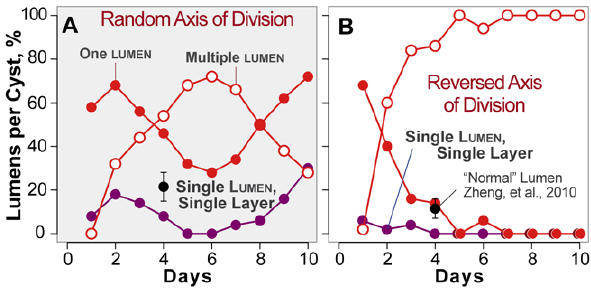
Figure 6. Percentage of ISMA CYSTS with varied LUMEN number when the axis of CELL DIVISION is abnormal. Shown are the percentages of CYSTS that have single (solid red circles) or multiple (open red circles) LUMENS when the axis DIVISION is (A) random or (B) reversed (rotated 90 u ) along with the percentage of CYSTS that are SLSL (purple circles) when the axis of CELL DIVISION is (A) random or (B) reversed. Black (A and B): mean and standard deviation for ‘‘normal’’ MDCK cysts observed by Zheng et al. [6]. The in vitro control data are shown in Figure 3.